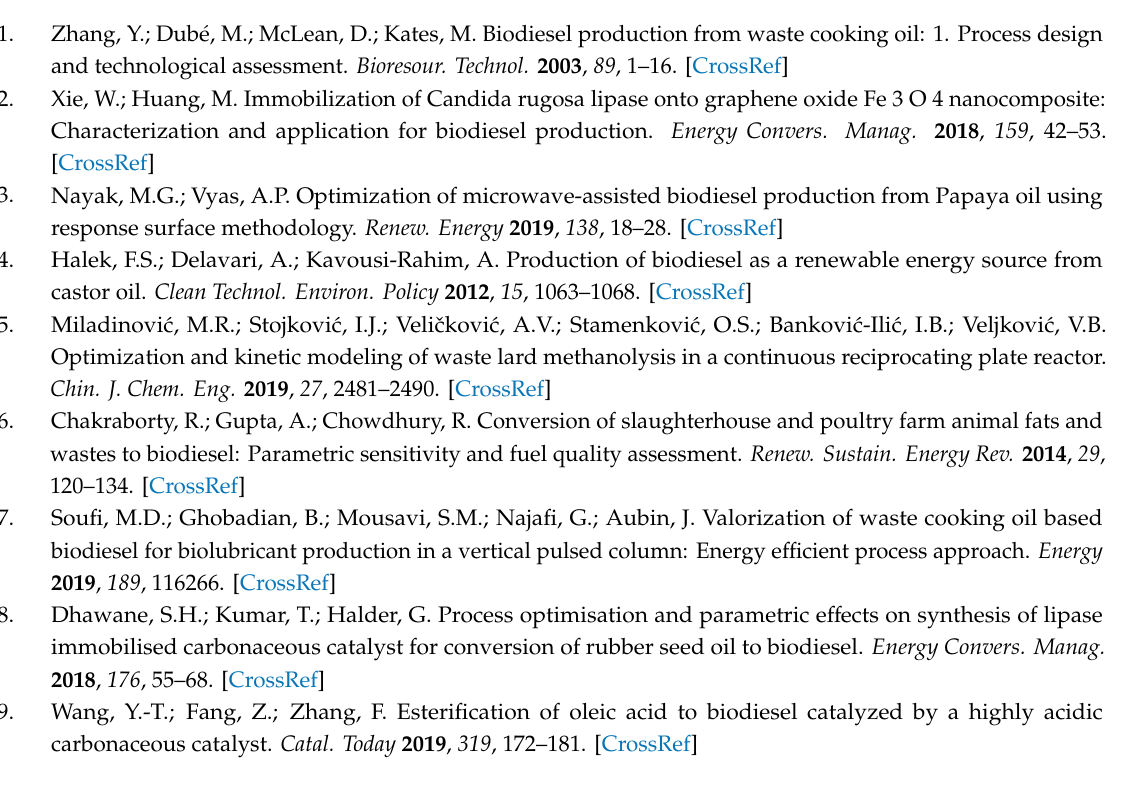
Figure S1: E ff ect of immobilization conditions on the relative activity and the amount of bound protein, Figure S2: Gas chromatography of biodiesel synthesized by immobilized